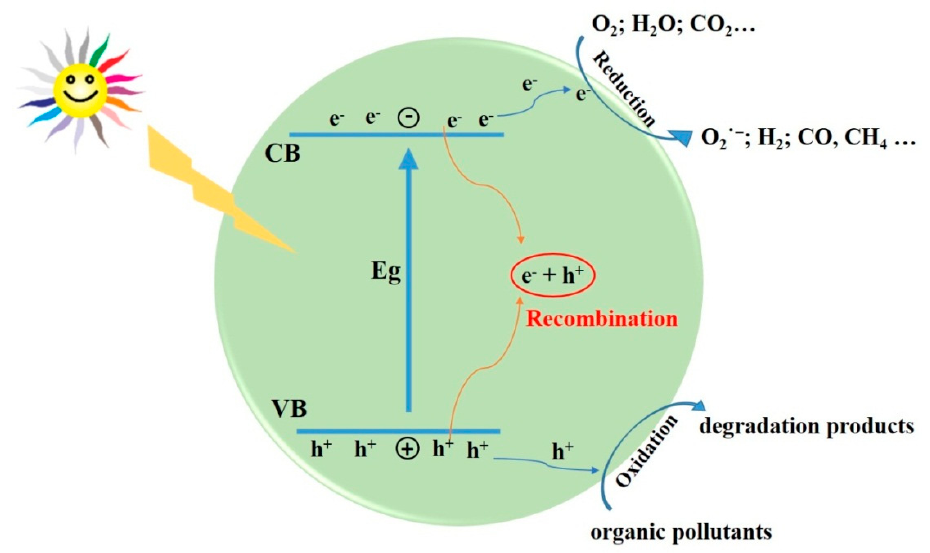
Figure 1. Photocatalytic process in semiconductor.